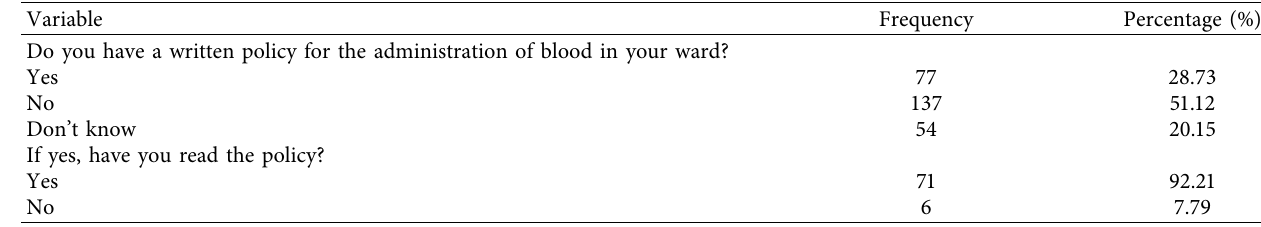
Table 10: Availability of the blood transfusion policy and guidelines.